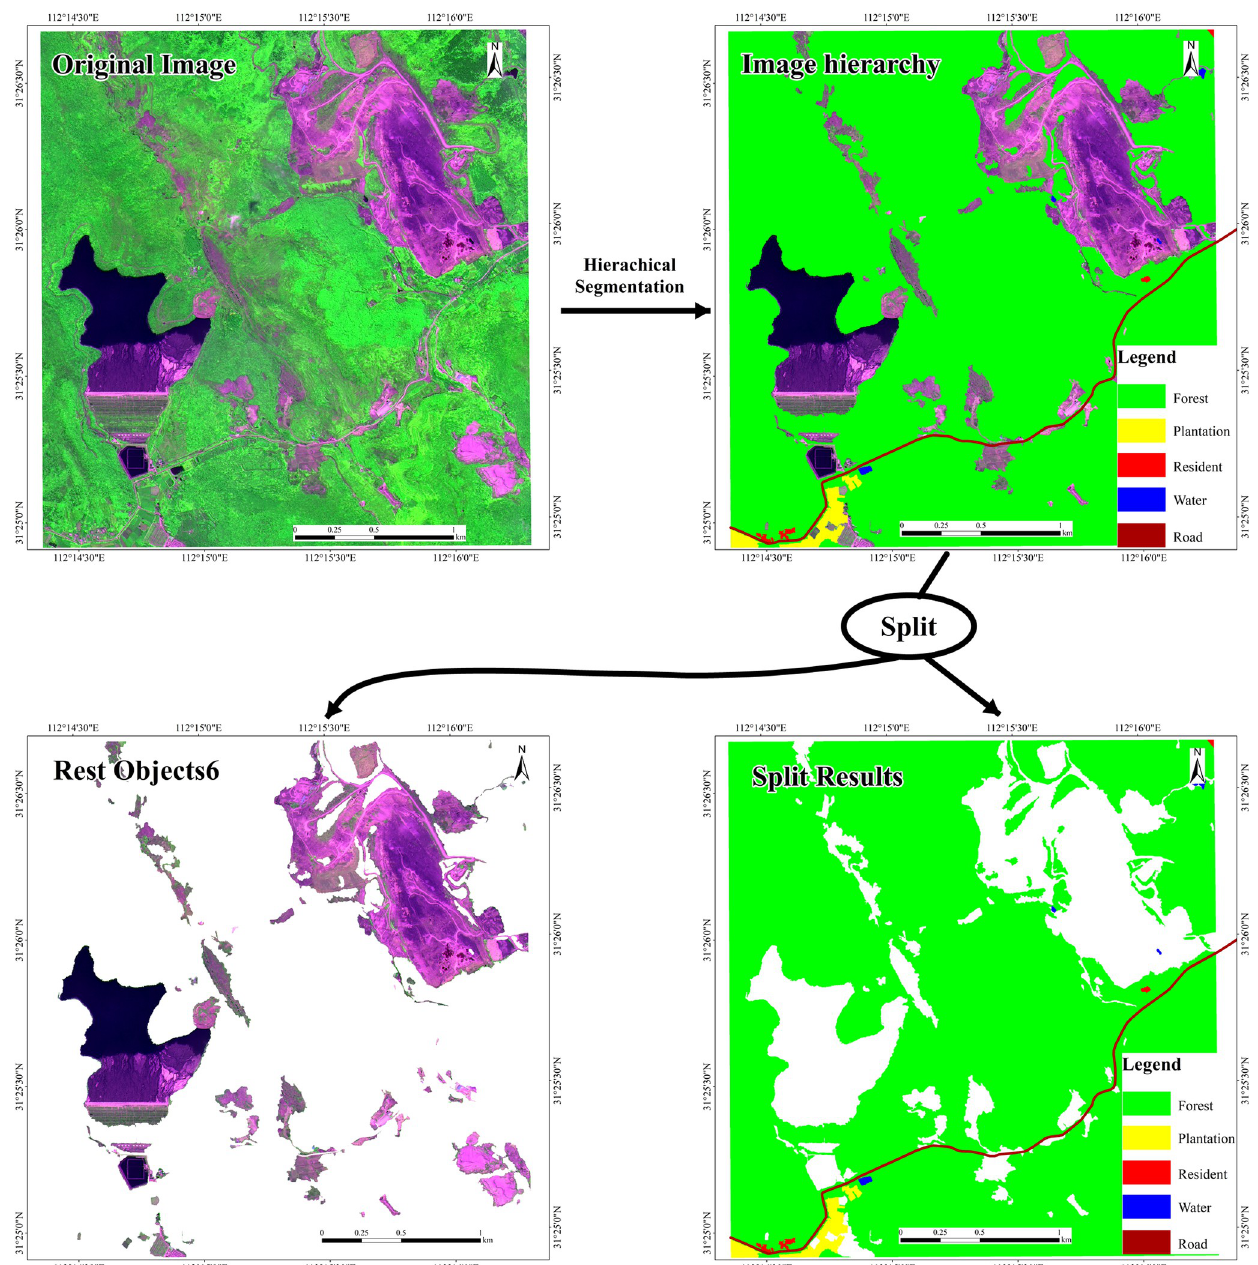
Fig 4. Differentiation layer extraction result graph of test area. Republished under a CC BY license, with permission from HBUT, original copyright 2017.